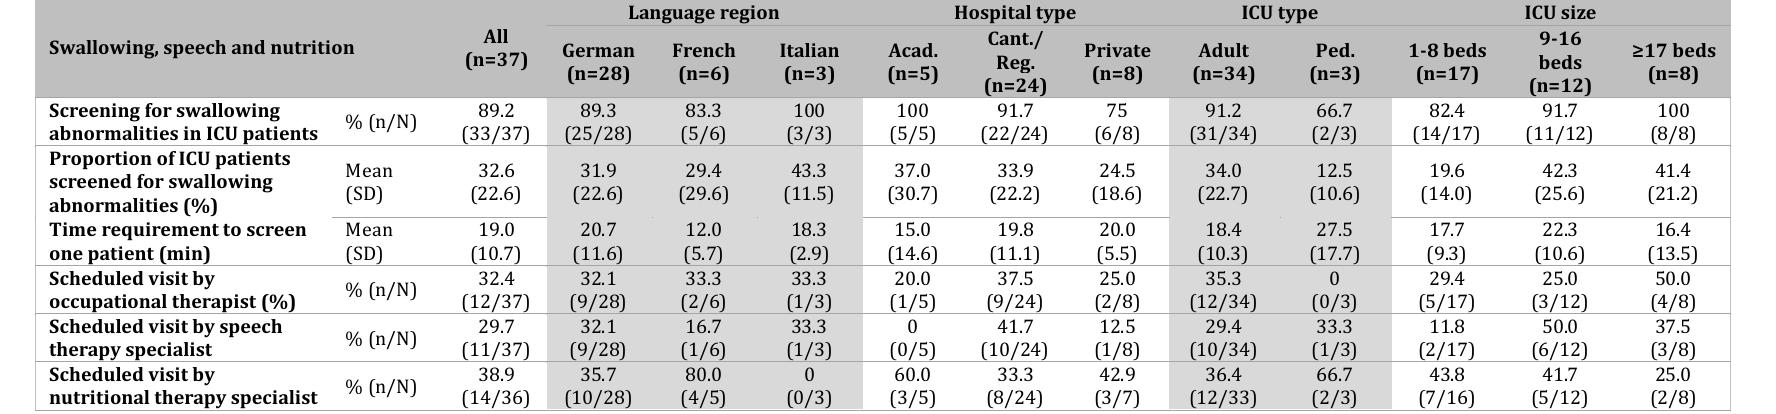
Table S17. Swallowing, speech, and nutrition (including both adult and pediatric ICUs)